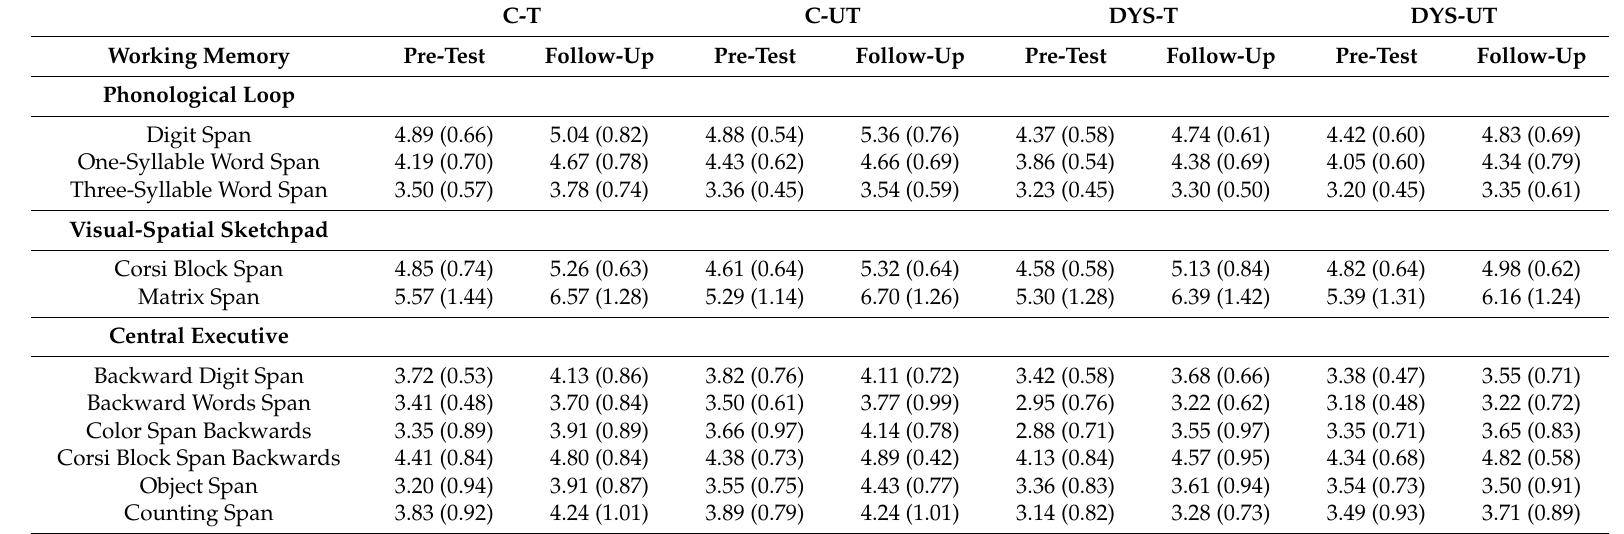
Table 2. Means (standard deviations) for working memory measures by subgroup.